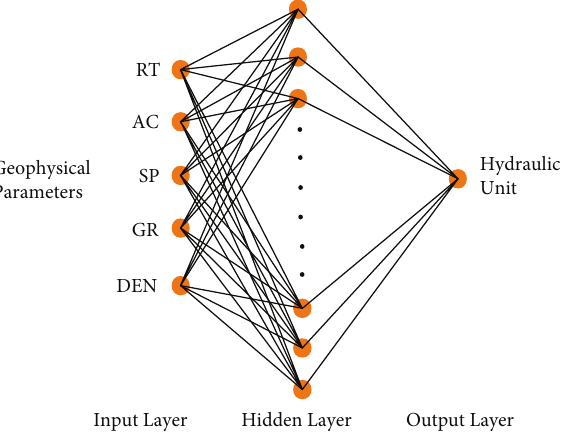
Figure 4: Schematic diagram of BP network